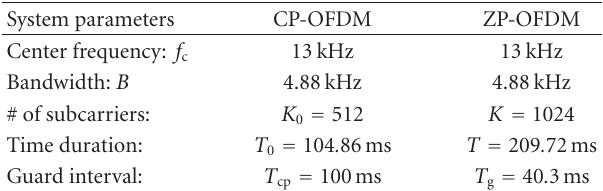
Table 1: OFDM parameters in